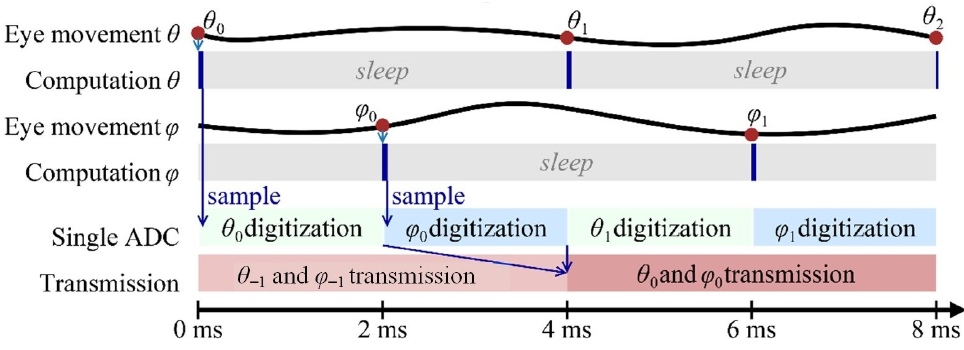
Figure 2. Time diagram for our system. Centroid computing units compute θ and φ are resting most of the time to save power. The results are sequentially sampled at 500 Hz.